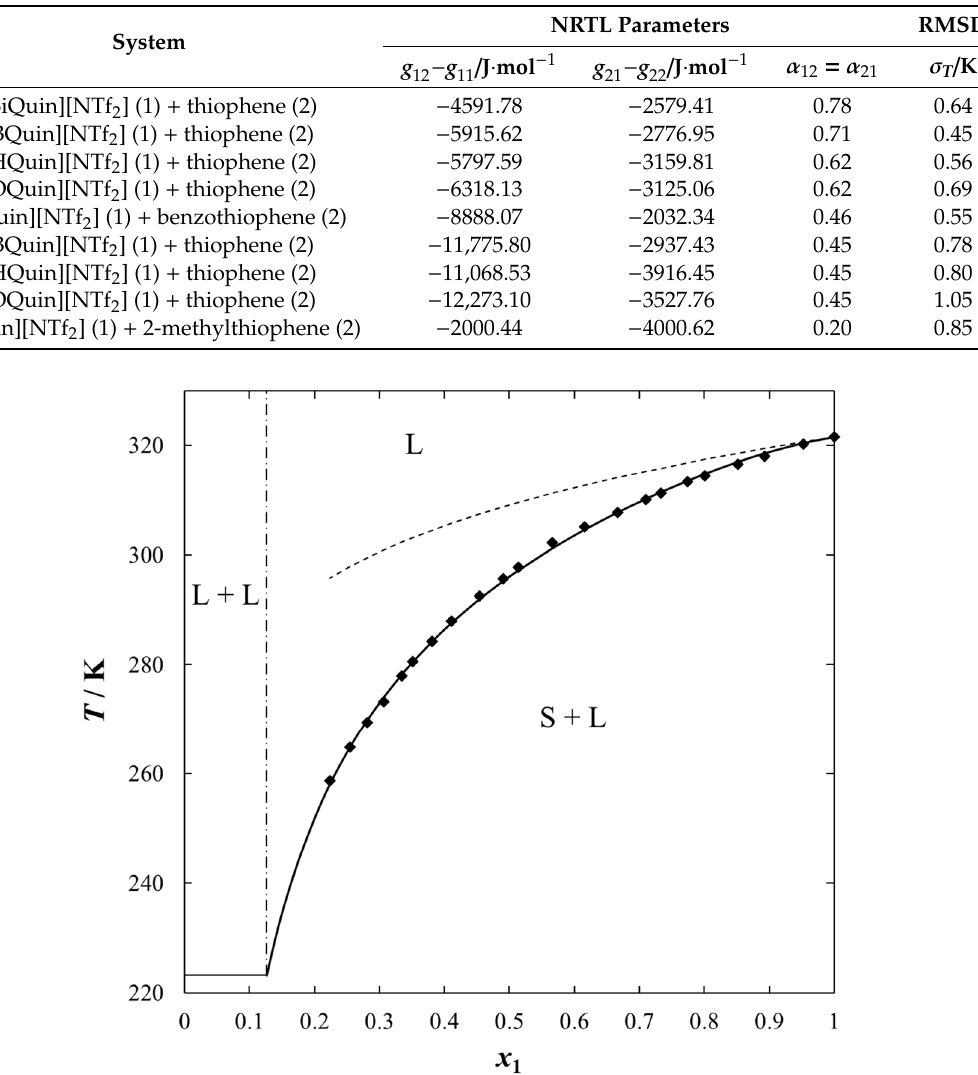
Figure 1. Experimental and calculated (solid + liquid), SLE and (liquid + liquid), LLE phase equilibrium data for {[BiQuin][NTf 2 ] (1) + thiophene (2)} binary system. Points show the experimental data; solid line is the correlation of NRTL model with parameters given in Table 5; dashed line is the ideal solubility; dash-dotted line is the experimental binodal curve.